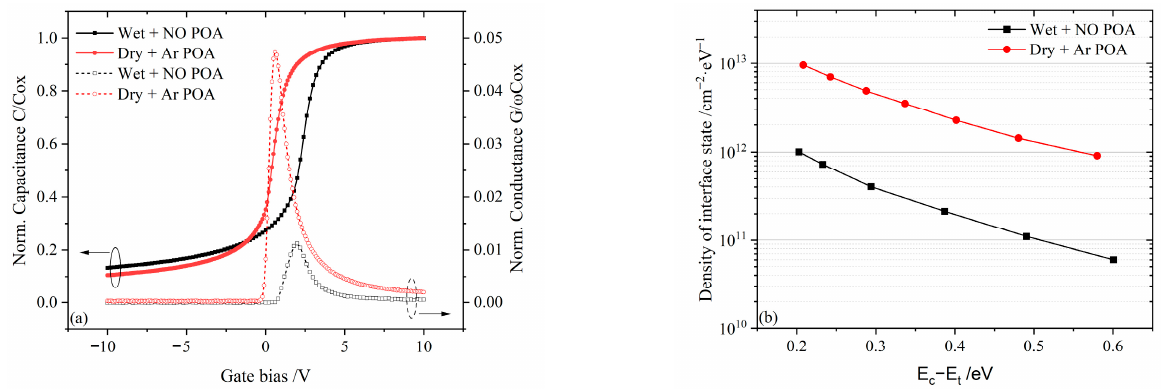
Figure 2. ( a ) C-V and G-V curves measured at 10 kHz for the fresh point and ( b ) D it extract by conductance method for the both samples.